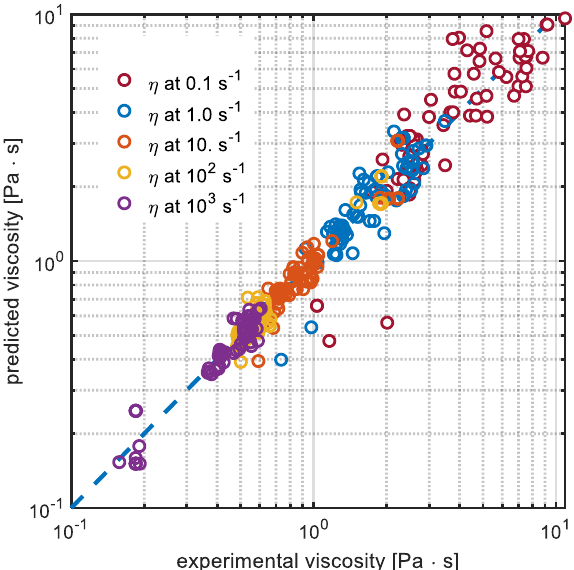
Figure 7. Comparison between experimental and calculated data for viscosity ( η ) at 0.1 (dark red circles), 1.0 (blue circles), 10 (red circles), 100 (yellow circles), and 1000 s − 1 (purple circles) for the training dataset.